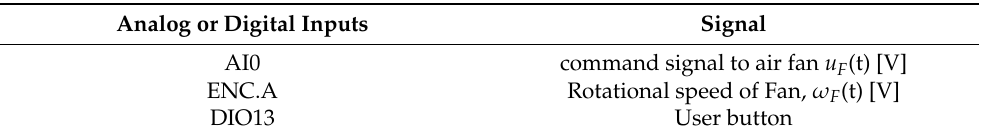
Table 4. Deusto Heater Experimental Setup—Analog and digital signals connected to the control hardware through the I/O interface.